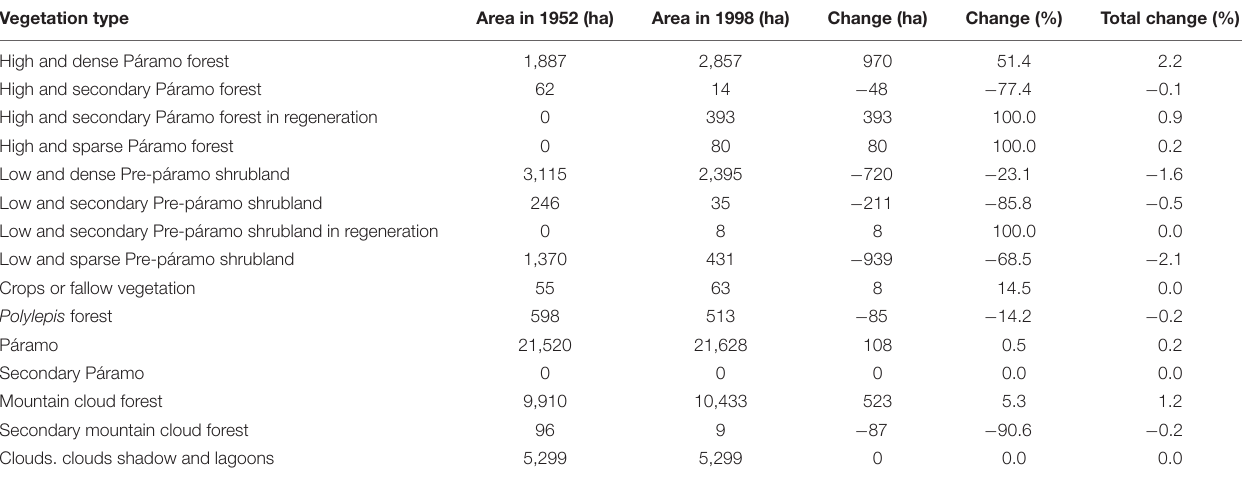
TABLE 4 | Vegetation types change in the Sierra Nevada National Park between 1952 and 1998. Vegetation